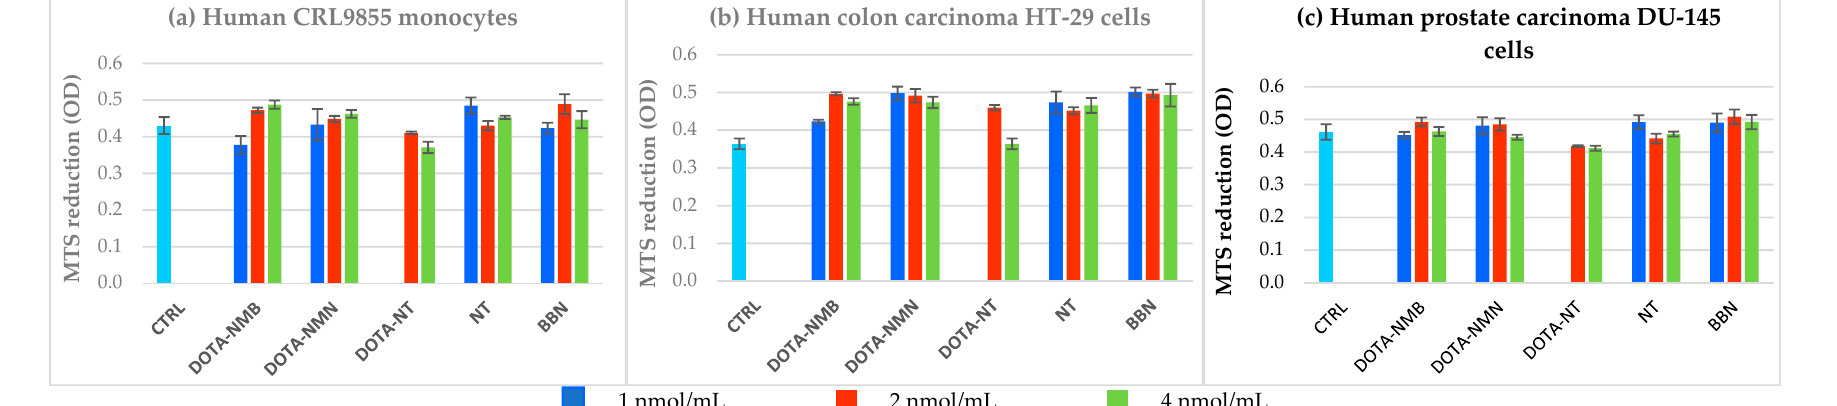
Figure A3. The effect exerted by neuropeptides on MTS reduction by human CRL955 monocytes ( a ), human colon carcinoma HT ‐ 29 cells ( b ) and human prostate DU ‐ 145 carcinoma cells ( c ) in 48 h cultures. Results are presented as mean ± SEM (standard error of the mean) for triplicate samples.